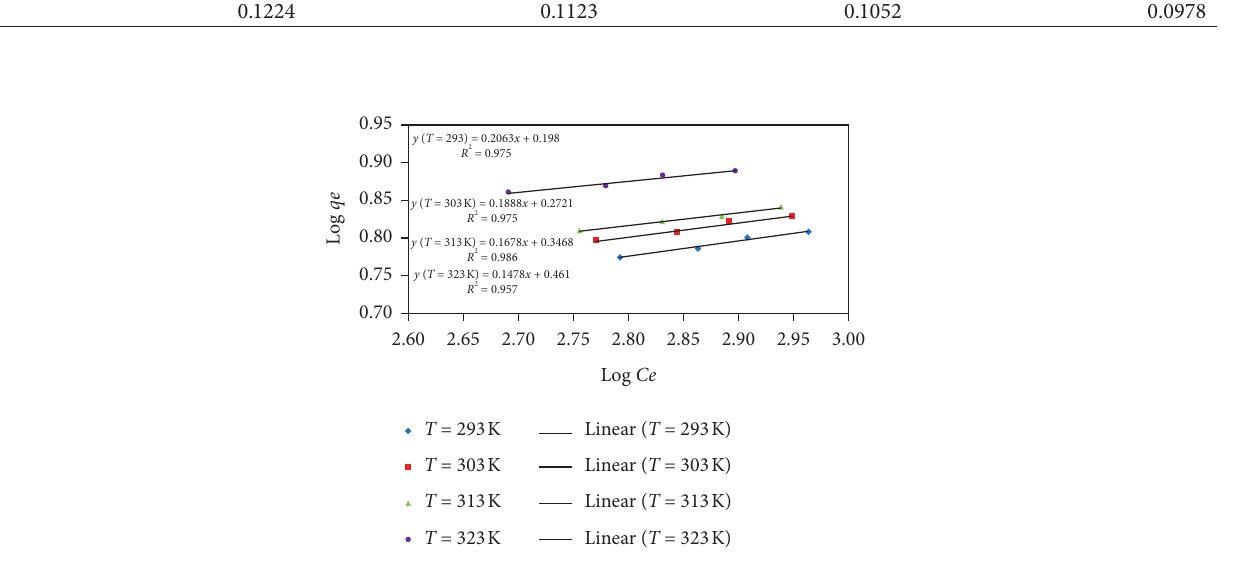
Figure 10: Freundlich plot for the adsorption of TPC onto AJB. Adsorbent dosage � 1.0g 10mL of OMW, pH � 6, contact time � 3 h. Table 3: Langmuir and Freundlich isotherm parameters for the adsorption of TPC onto